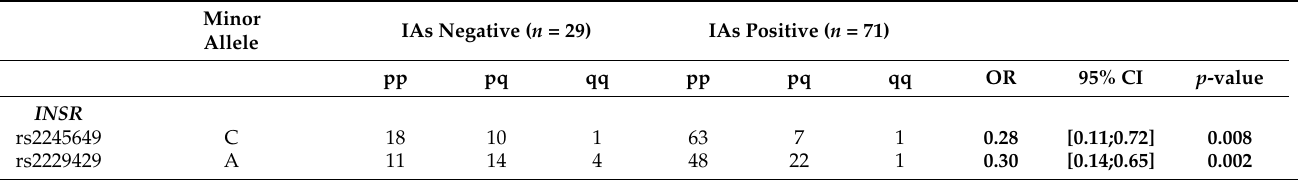
Table 4. Associations between selected polymorphisms in the INSR gene and the presence of anti- insulin antibodies in